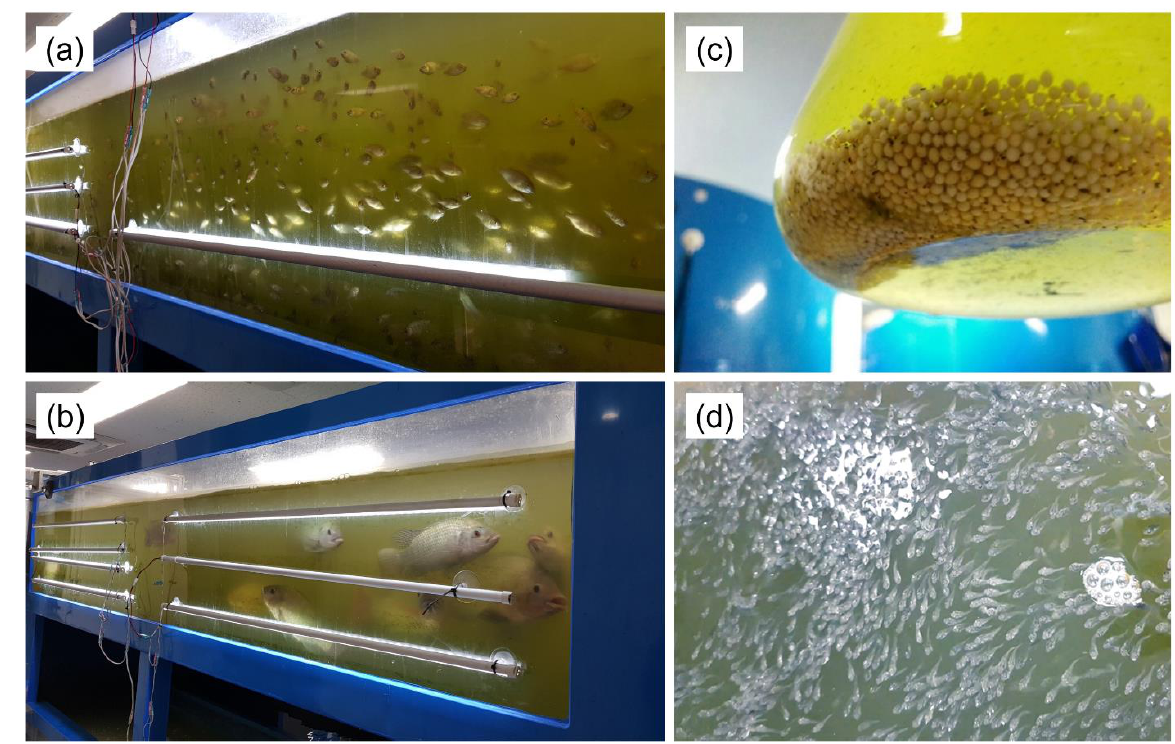
Figure 4. In ABFT tanks, average concentration of initial microalgal cells for inoculum every 10 days was less than 0.2 g L −1 . (a) Growth from hatching to juvenile stage (> 600 fish, < 10 g) in ABFT system for 4 weeks with no water replacement at 2,000 L water capacity. The fish were fed 3 times per day (9:00, 13:00 and 17:00) at 3-5% of wet body weight. (b) Growth to adult stage (> 130 fish, 350 - 550 g) in ABFT system for 6 weeks with 5% water replacement every 3 days at 2,000 L water capacity. The fish were fed 3 times per day (9:00, 13:00 and 17:00) at 1-3% of wet body weight. (c) Eggs and (d) fry produced from ABFT system at 2,000 L water capacity.